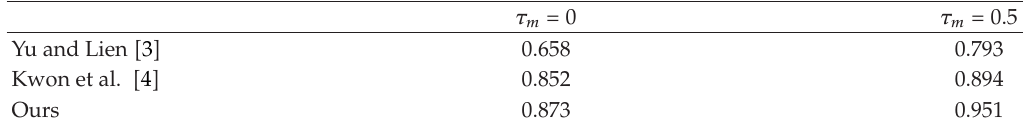
Table 3: Maximum allowable upper bounds τ M of the time-varying delay for di ff erent values of the lower bounds τ m and c (cid:9) 0 . 1.